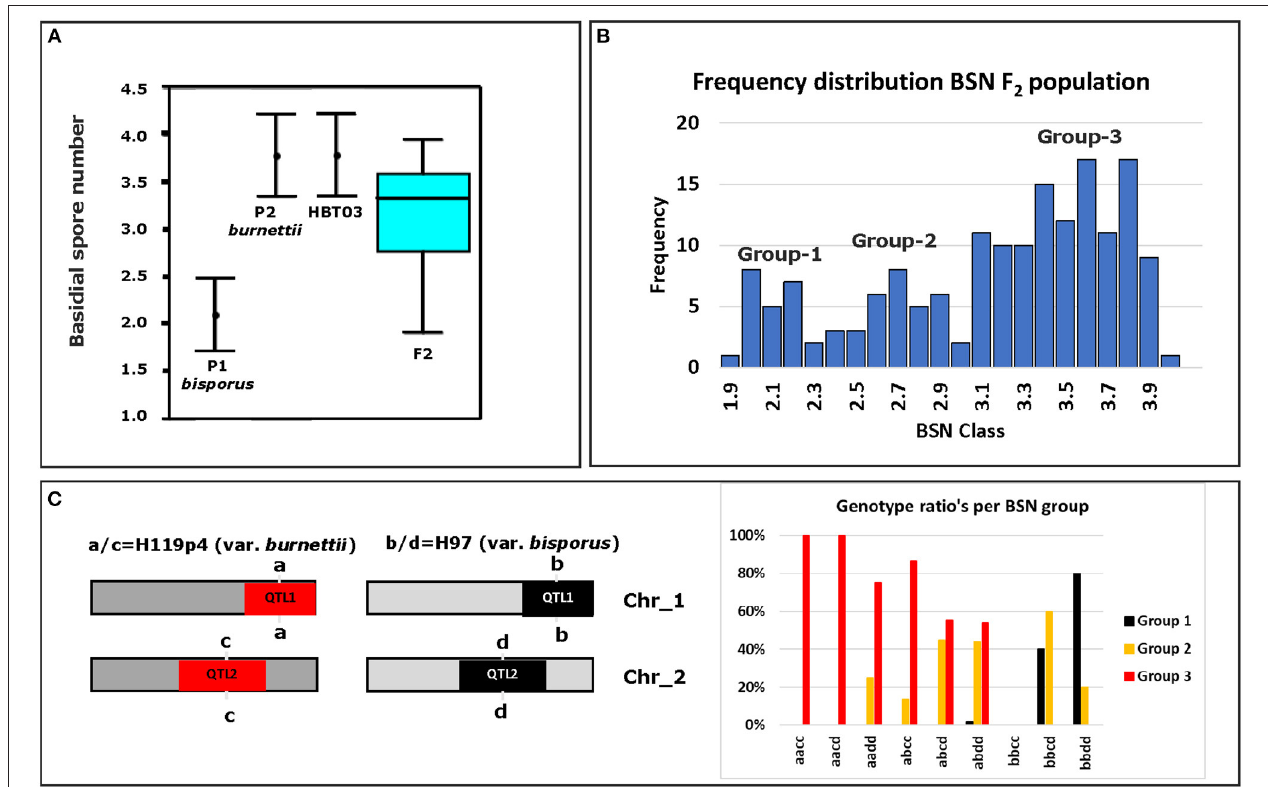
FIGURE 3 | Basidial spore number (BSN) of parents, F 1 and F 2 intercross. (A) Averages and standard deviations of BSN of the parental lines (P1 [var. bisporus Horst U1] and P2 [var. burnettii 119/9]) and a box plot of the variation of BSN in the F 2 intercrossed homokaryotic offspring of HBT03. The bar in the box indicates the median BSN. (B) Frequency distribution of average spore number of the F 2 intercrossed population. Three groups can be discriminated with variation of BSN around 2.1, 2.8, and 3.6. Bin size is 0.1. (C) Left, the schematic representation of the genotypes on chromosomes 1 and 2 for the SNP-marker at the peak of each QTL for both parental homokaryons. Right, the frequency distribution of genotypes of the F 2 intercrossed population normalized for the number in each